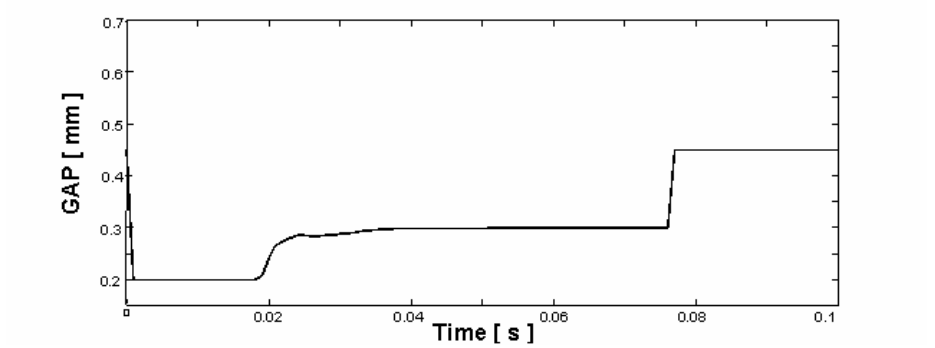
Fig. 14. Gap imposed by the fuzzy